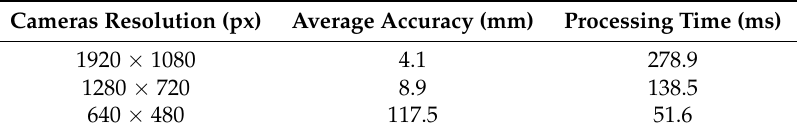
Table 1. Average accuracy and processing time of detection in